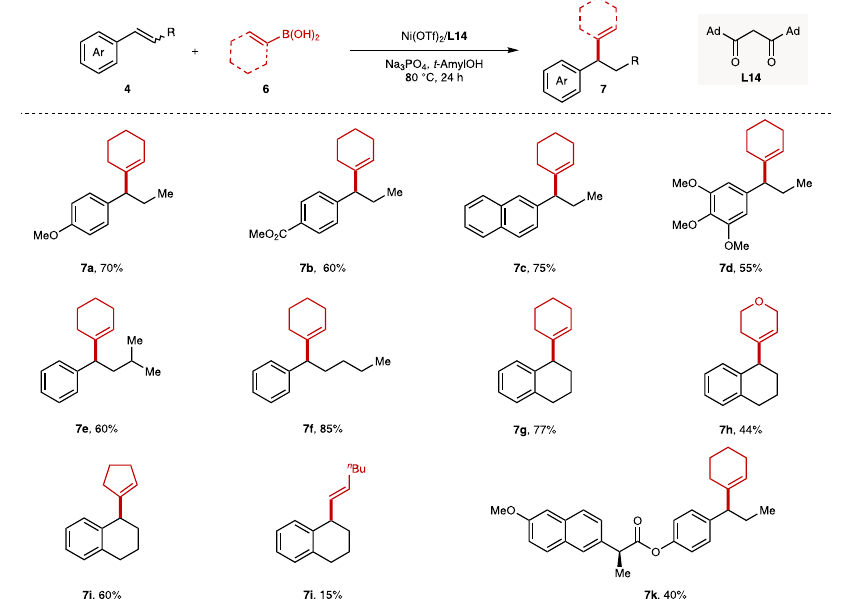
Fig. 5 | Hydroalkenylation of internal alkenes with alkenyl boronic acids. The values under each structure indicate isolated yields. The regioselectivity was determined by analysis of the crude 1 H NMR (rr>99/1 for all substrates). Reaction conditions: 4 (0.2mmol, 1.0 equiv), 6 (0.6mmol, 3.0 equiv), Ni(OTf) 2 (10mol%),